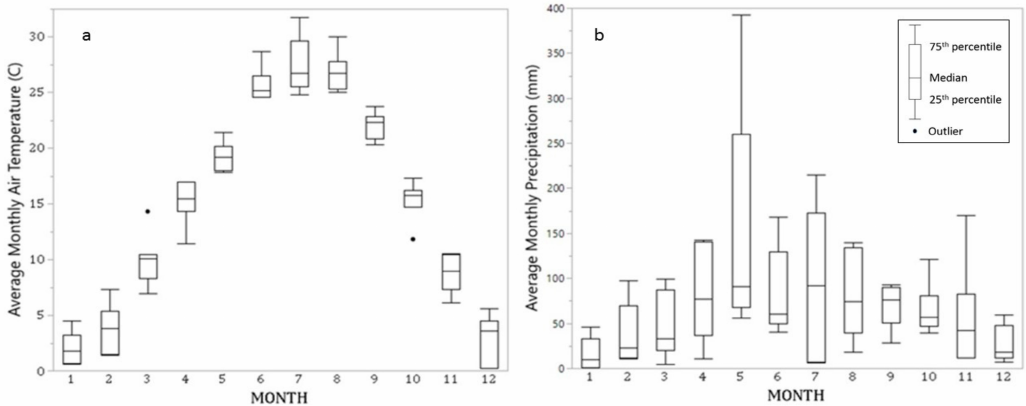
Figure 3. Box plots of monthly ( a ) temperature and ( b ) precipitation for 2009–2015, El Reno, Oklahoma. Month 1 = January ... Month 12 = December. Data Source: Oklahoma Climate Survey, http: //